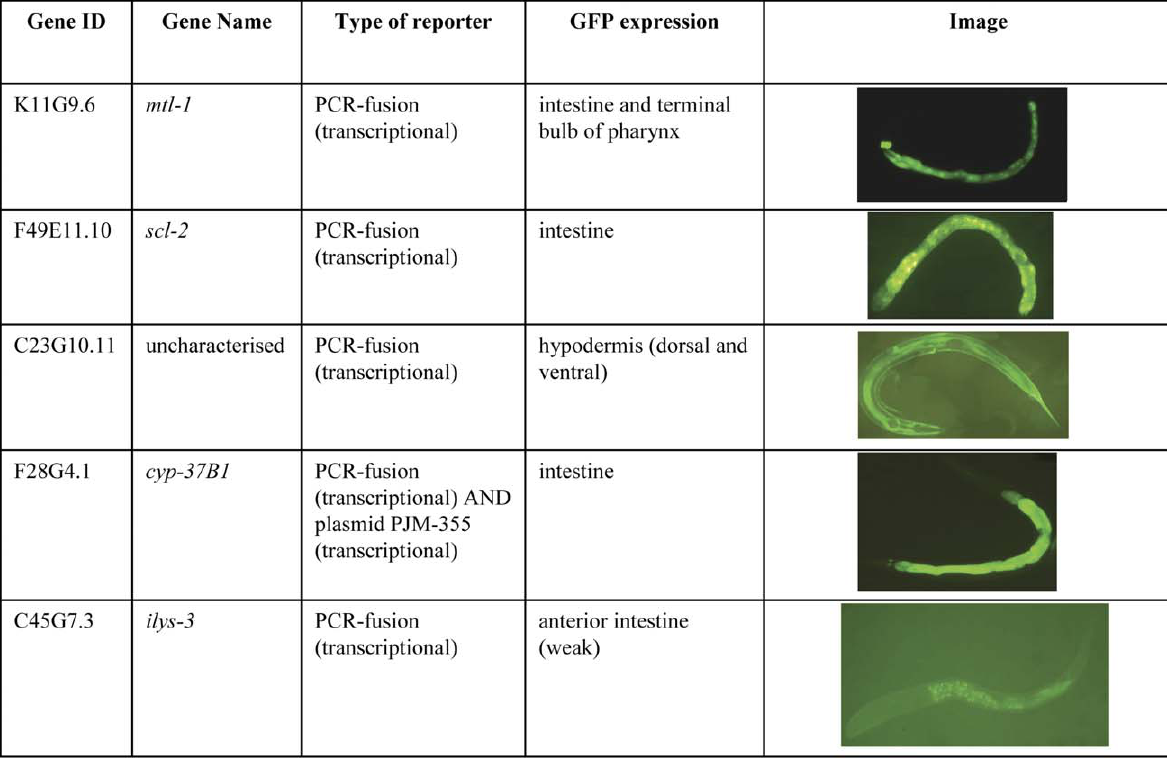
Figure 6. GFP expression patterns of IVM responsive genes. mtl-1 , scl-2 , cyp-37B1 and ilys-3 are expressed in the intestine and C23G10.11 is expressed in the hypodermal cells. These are both proposed sites of fat storage.